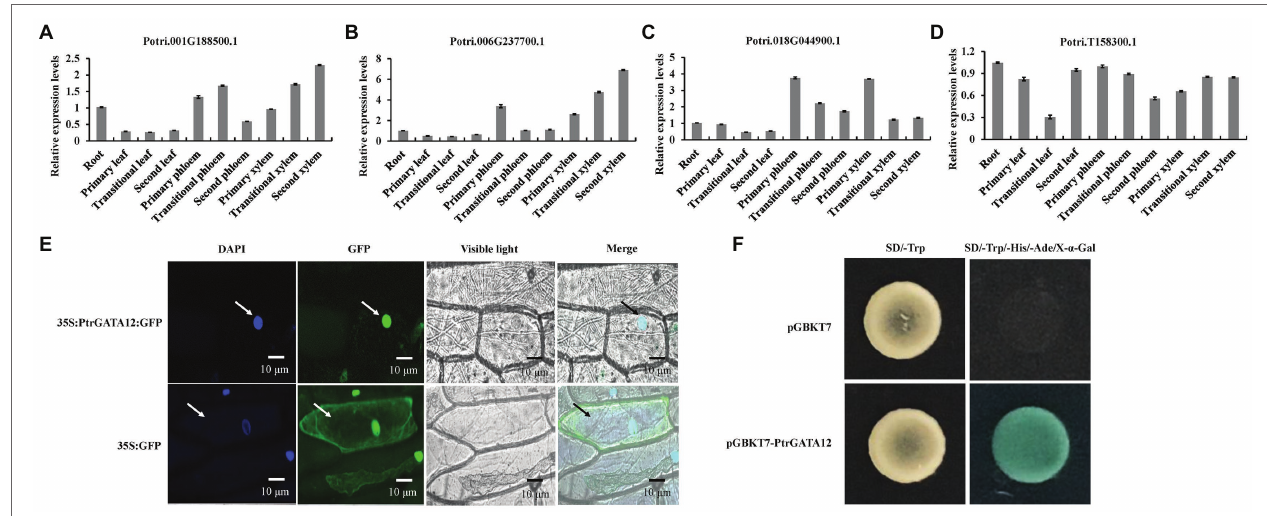
FIGURE 2 | Tissue-specific expression patterns, subcellular localization and transcriptional activity of PtrGATA12. (A) The tissue-specific expression patterns of Potri.001G188500 gene as determined by quantitative RT-PCR (qRT-PCR) analysis. (B) The tissue-specific expression patterns of Potri.006G237700 gene as determined by qRT-PCR analysis. (C) The tissue-specific expression patterns of Potri.018G044900 gene as determined by qRT-PCR analysis. (D) The tissue- specific expression patterns of Potri.T158300 gene as determined by qRT-PCR analysis. PtrActin was used as a control. Error bars represent the SD of three biological replicates. (E) Subcellular localization of PtrGATA12. Confocal images manifested the localization of PtrGATA12-green fluorescent proteins (GFP) in the nuclei of onion epidermal cells. DAPI, a nuclear staining dye; Merged: the merged images of bright-field, GFP, and DAPI staining. Arrows indicate cells located in the epidermis of onions. (F) Transcriptional activation analysis of PtrGATA12 fused with the GAL4 DNA binding domain (GAL4DB) in yeast shows its potential to activate the expression of the His-3 and X- α -Gal reporter